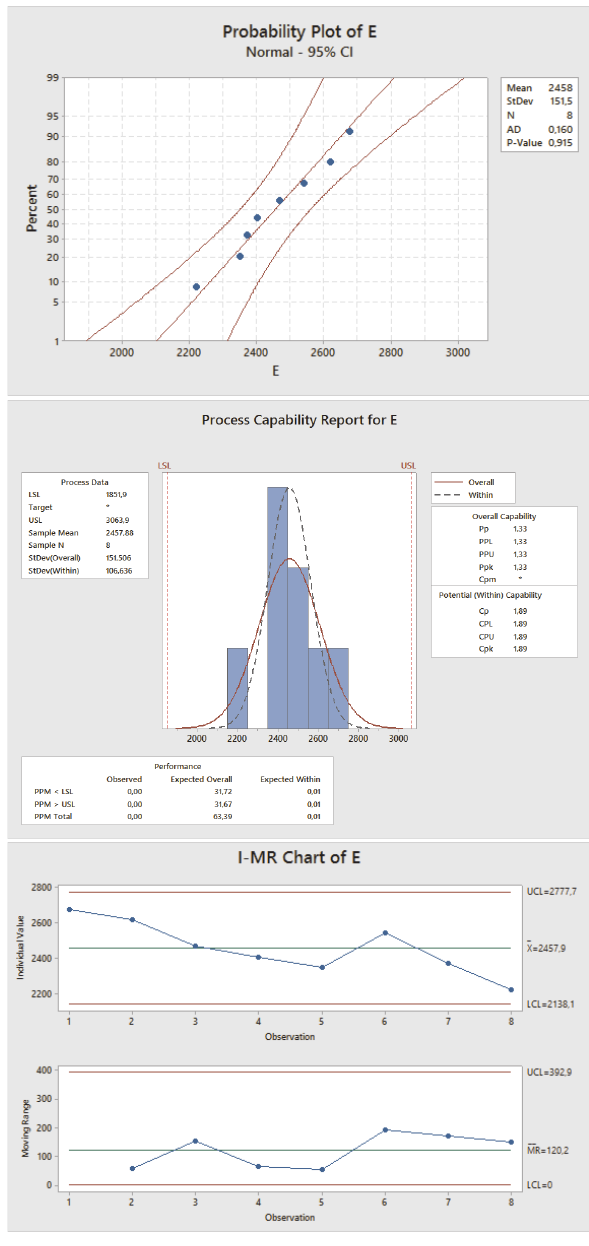
Figure 23: Probability Plot, Process Capability Report and I-MR Chart for the Young modulus E of